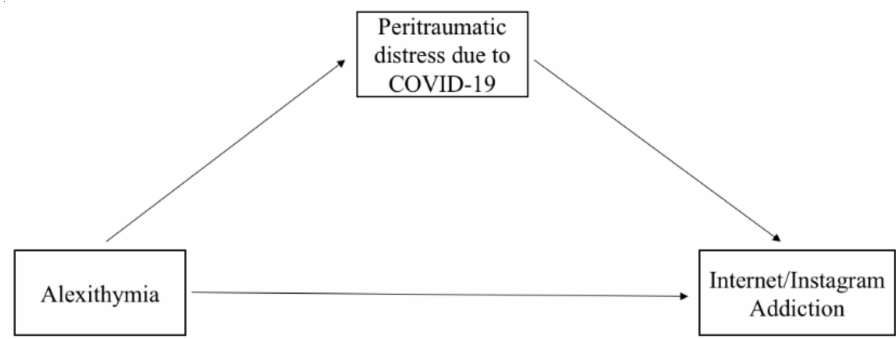
Figure 1. Mediation model to be